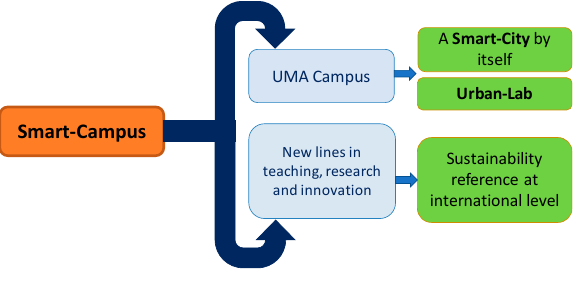
Figure 3. Objectives.